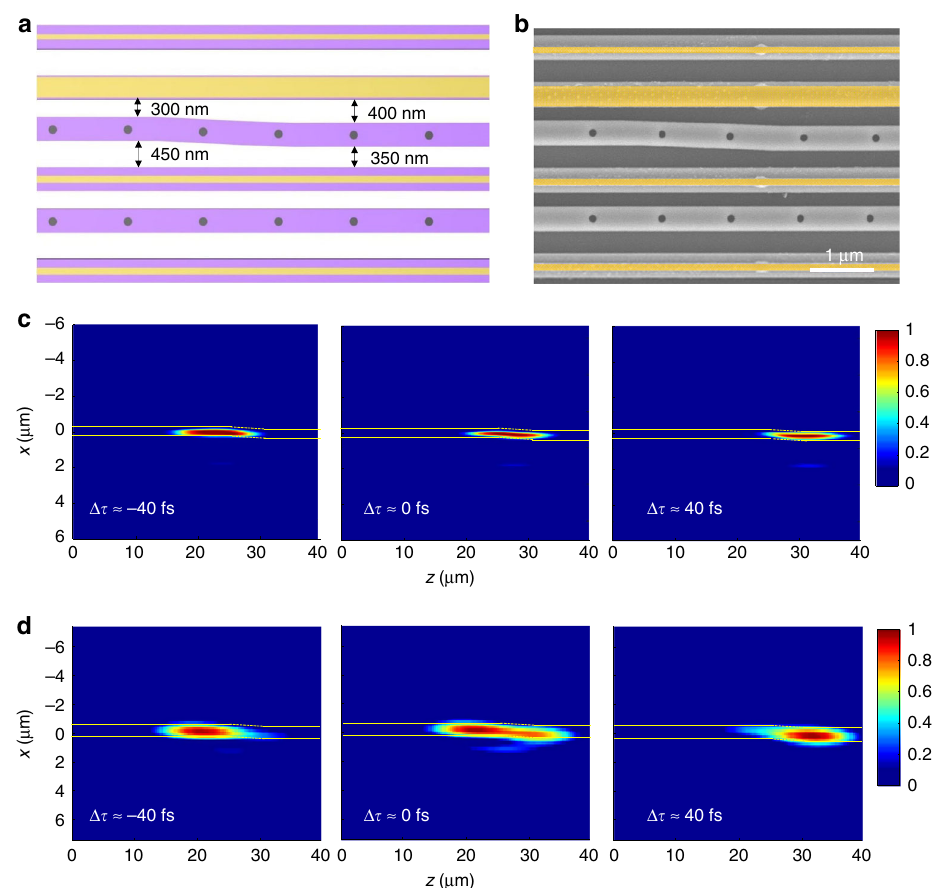
Fig. 4 Experimental validation of the robustness of the zero mode. a The interface waveguide is adiabatically shifted 100 nm toward the PT symmetric semi-lattice over a distance of 5 µ m in the z direction, reversing the local topological order around the interface from t A / t B = 2.5 to t A ′ = t B ′ ¼ 0 : 8. b SEM picture of the topology-transition region implemented in the Si waveguide array, where pseudo yellow color denotes the Cr depositions. The dimensions of each waveguide remain the same compared with the sample in Fig. 2c. c and d are numerically simulated ( c ) and experimentally ( d ) measured ultrafast dynamics of the zero mode to probe its robustness against topological disorders. Snapshots at different time delays show the pulse entering, propagating, and exiting around the topology-transition Supplementary Fig. 3. The spatiotemporal reconstruction of the pulse is achieved using the Fourier transform method. In the spectrum, the fi rst order of the interference pattern reveals the spatial envelop of the pulse. The pulse distribution is reconstructed through the process of the spectrum cyclic shift, low pass fi ltering, and inverse Fourier transform.